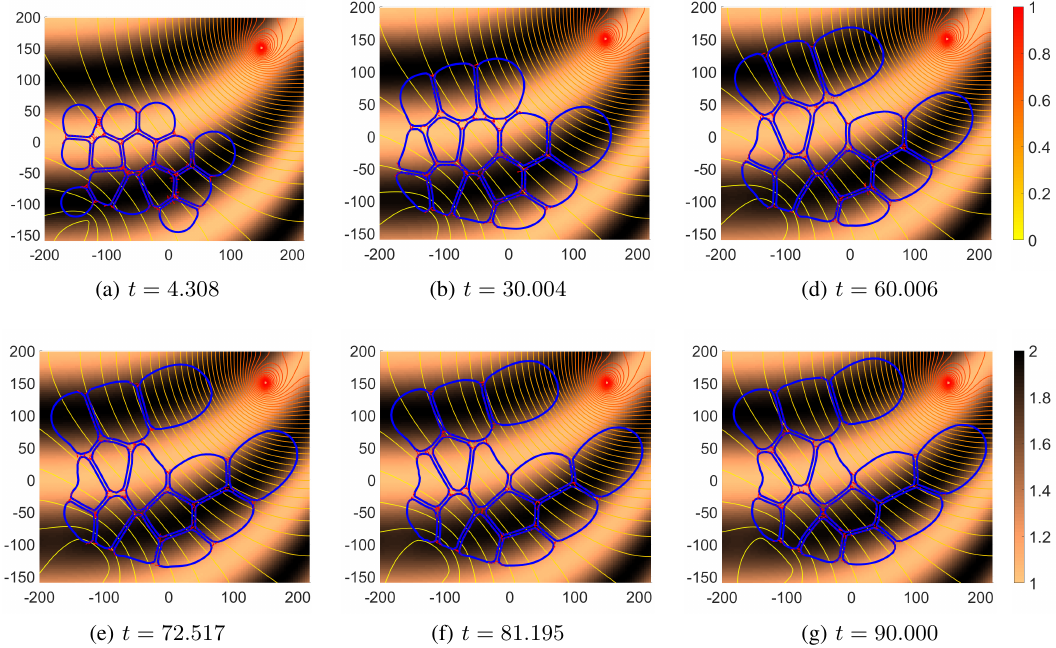
Fig. 8. Experiment 3 (Cluster formation). A number of 14 FBLM cells are placed in a non-uniform and adaptive environment. The cells collide and adhere with each other, and respond haptotactically to the gradient of the ECM (shown here as the background landscape with the corresponding colorbar in the second row) and chemotactically to the chemical gradient (shown as isolines with the colorbar in the first